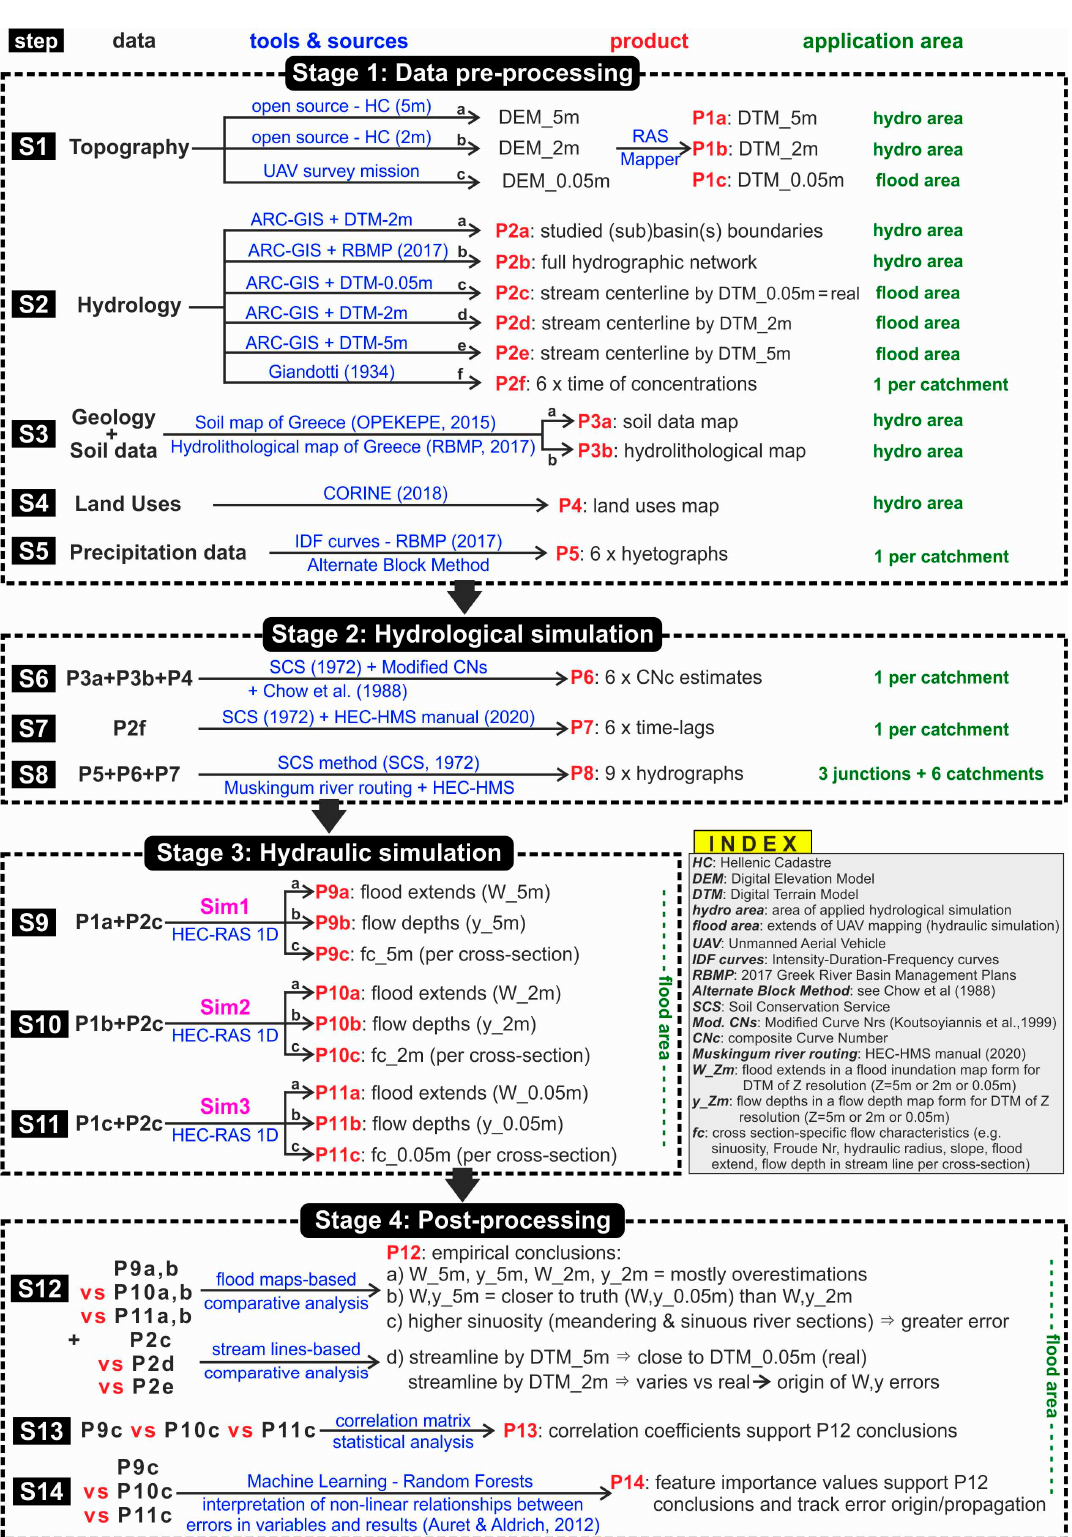
Figure 1. Graphical abstract of the methodology implemented to investigate the sensitivity of flood risk mapping via 1D hydraulic simulations vs. various DEM resolutions. Aim: conclude on study area features that render the use of more accurate but costly and time-consuming UAV mapping imperative and decide on the next best free alternative option in Greek reality.